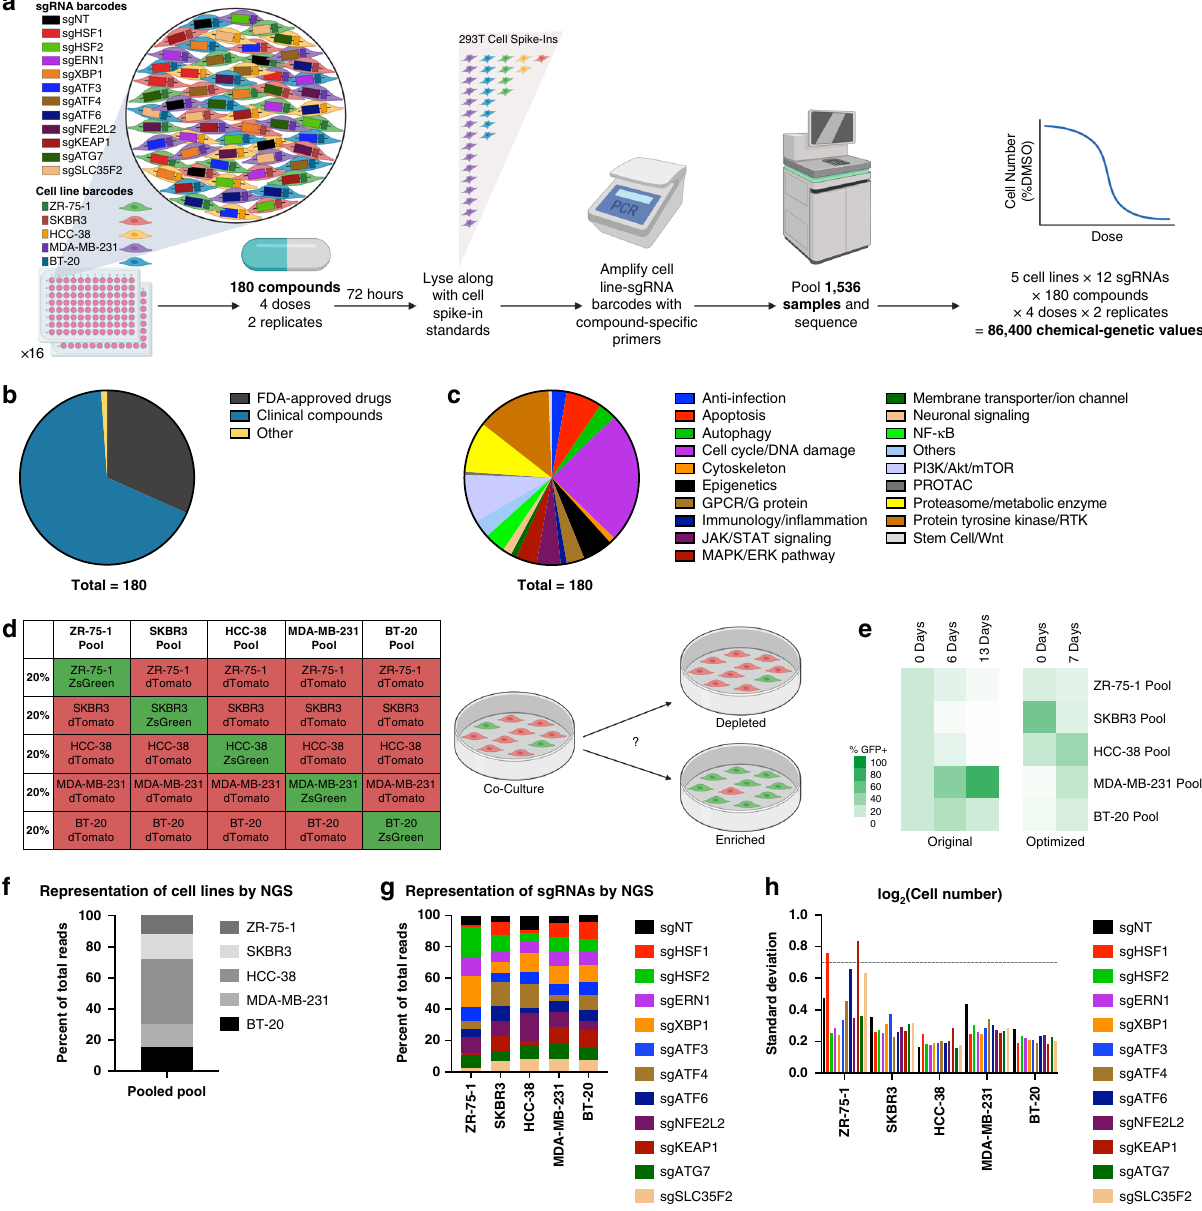
Fig. 2 Expanding QMAP-Seq to multiple cell lines. a Experimental work fl ow for QMAP-Seq with fi ve cell lines. b Pie chart showing breakdown of 180 compounds by stage of development. c Pie chart showing breakdown of 180 compounds by pathway. d Schematic of competition experiment to optimize the starting representation of the fi ve co-cultured breast cancer cell lines. Original cell line pools were prepared by mixing equal numbers of one cell line expressing ZsGreen with each of the other four cell lines expressing dTomato. Flow cytometry analysis measured the percentage of GFP positive cells in each pool over time. e Heat maps displaying the percentage of GFP positive cells at various time points as measured using fl ow cytometry. Left: Original cell line pools that started with 20% of each cell line on Day 0. Right: Optimized cell line pools predicted to contain 20% of each cell line on Day 7. Source data and gating strategy are provided as a Source data fi le. f Representation of fi ve breast cancer cell lines as measured by counting the number of sequencing reads for each cell line barcode across the 96 DMSO samples. g Representation of sgRNAs as measured by counting the number of sequencing reads for each sgRNA barcode relative to the total number of sequencing reads for that cell line across the 96 DMSO samples. h Standard deviation of the interpolated cell number for each cell line-sgRNA pair across the 96 DMSO samples. Dotted line indicates threshold for excluding cell line-sgRNA pairs with high variability. Source data are available in the Source data fi le. We also observed suf fi cient representation of most cell line- sgRNA pairs (Fig. 2g). Unsurprisingly, the two cell line-sgRNA pairs with the lowest representation in the pool (ZR-75-1 sgHSF1 and ZR-75-1 sgKEAP1) exhibited the greatest variation between DMSO samples (standard deviation >0.7) and were thus excluded from downstream analysis (Fig. 2h). NATURE COMMUNICATIONS| (2020) 11:5722